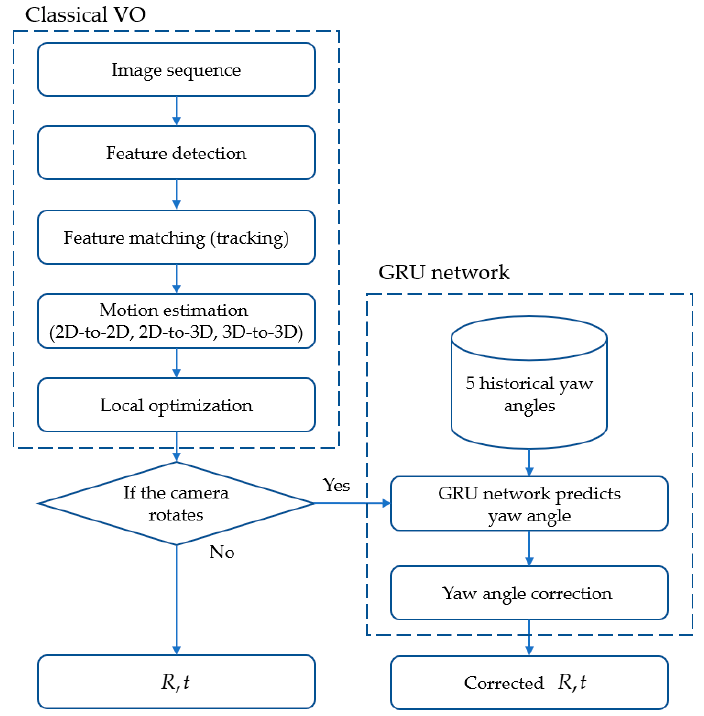
Figure 7. Proposed pose estimation framework with classical VO.